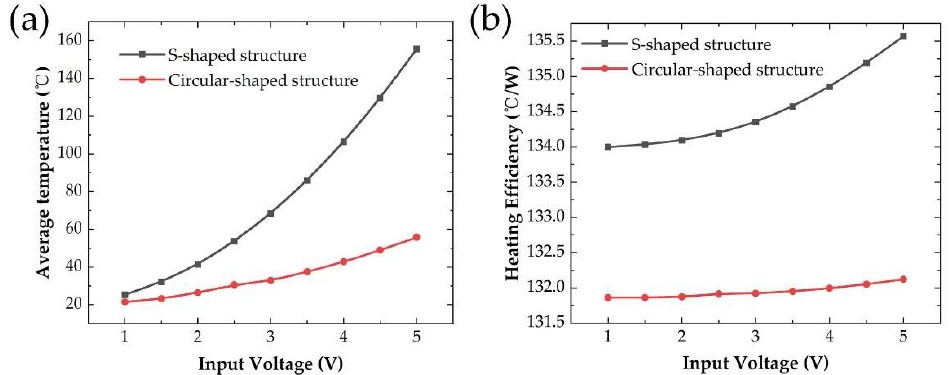
Figure 4. ( a ) The steady-state average temperature, ( b ) Heating efficiency for the S-shaped and the Circular-shaped structure with different input voltage. Circular-shaped structure with different input